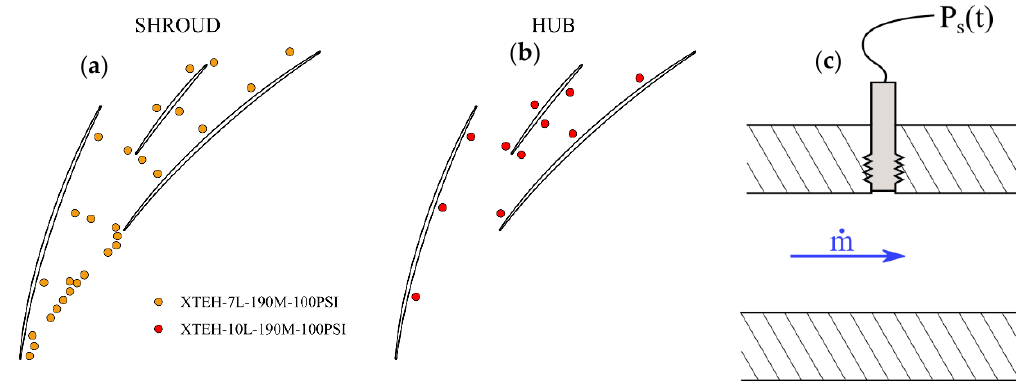
Figure 3. Projection of the unsteady pressure sensors in one passage of the radial diffuser ( a and b ) and scheme of a flush-mounted sensor in the shroud ( c ).